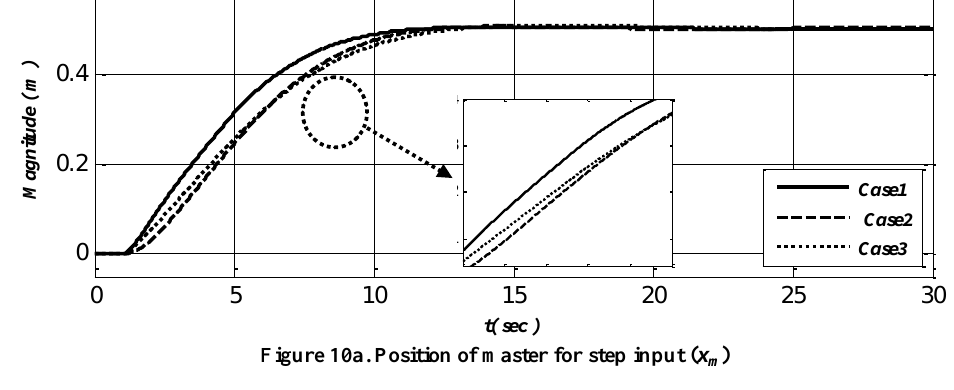
Figure 10a. Position of master for step input ( x m )